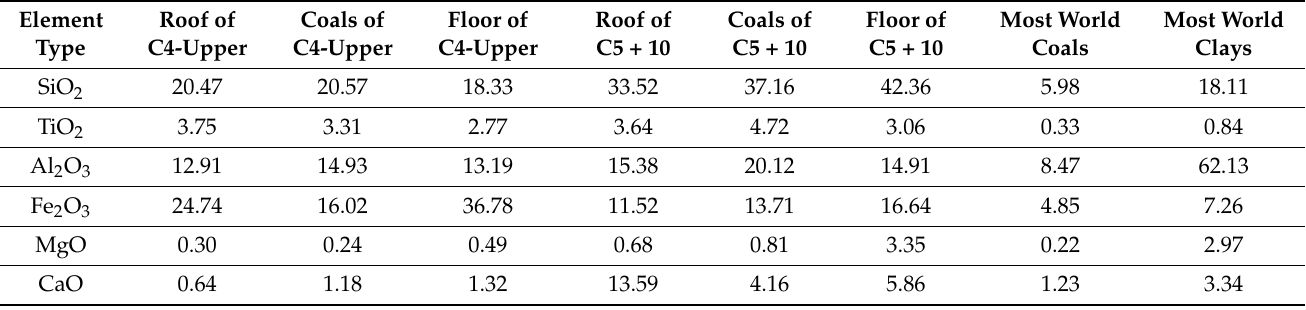
Table 2. Concentrations of major oxides and trace elements of all the